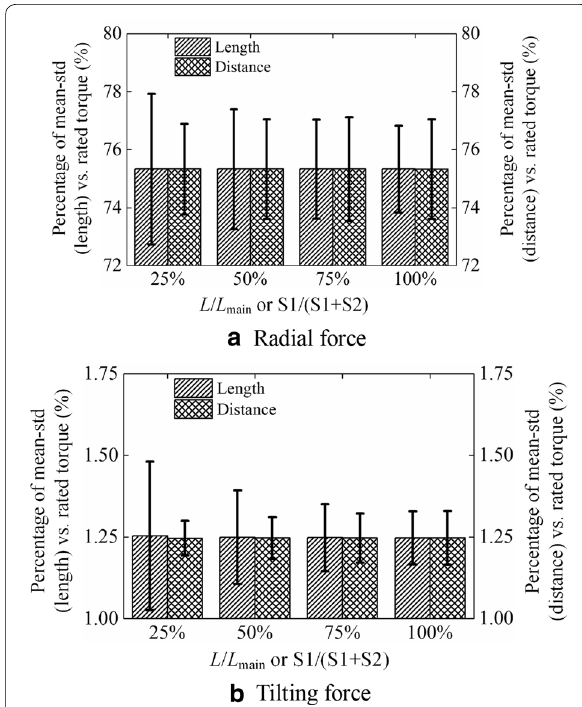
Figure 14 Planet bearing forces in two suspension configurations